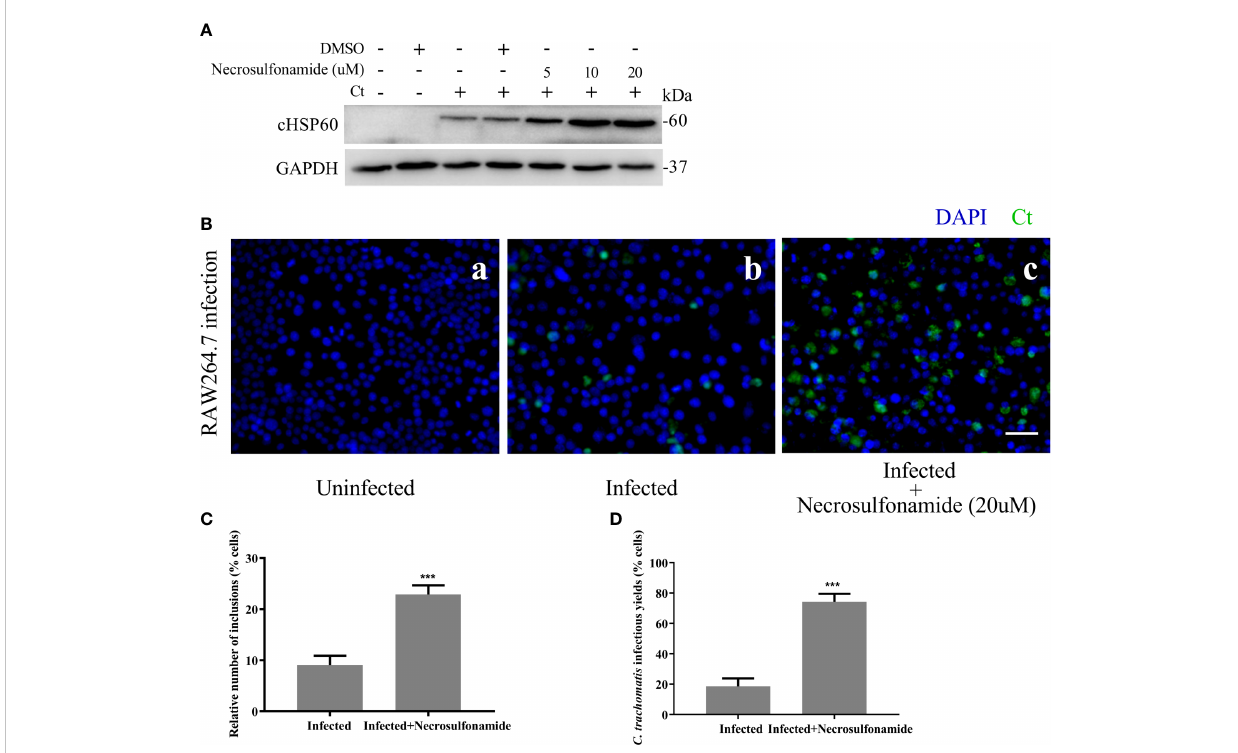
FIGURE 4 Blocking GSDMD pore-forming activity signi fi cantly increases the intracellular growth of C . trachomatis. (A) RAW264.7 cells were pretreated with Necrosulfonamide for 30 minutes, then infected with C . trachomatis (MOI=5) for 12 hours. The same concentration of Necrosulfonamide was maintained throughout the rest of the infection. Immunoblot analysis showed expression of cHSP60 in cell extract in RAW264.7 cells. (B, C) . RAW264.7 cells pretreated with Necrosulfonamide for 30 minutes, then infected with C . trachomatis (MOI=5) for 40 hours. Same concentration of Necrosulfonamide was maintained throughout the rest of the infection. (B) . Immuno fl uorescence microscopy analysis showed the growth of C . trachomatis in RAW264.7 cells. (C) . Quantitative analysis of inclusion number relative to nuclei in RAW264.7cells in (B) . (D) RAW264.7 cells were lysed to collect C . trachomatis infectious progenies to re-infect HeLa cells for 24 hours, and immuno fl uorescence microscopy quantitative analysis of inclusion number relative to nuclei in HeLa cells was used to estimate C. trachomatis infectious yields within RAW264.7 cells. Scale bars, 20 m m. ***P<0.001, vs the Infected group.